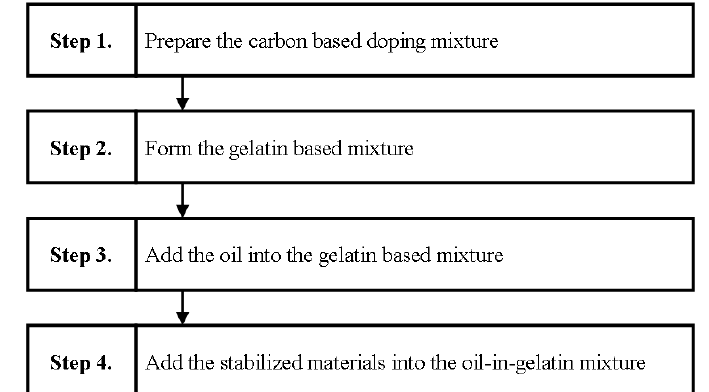
Figure 1. The main procedure of preparing the proposed oil-in-gelatin based materials doped with carbon based materials.